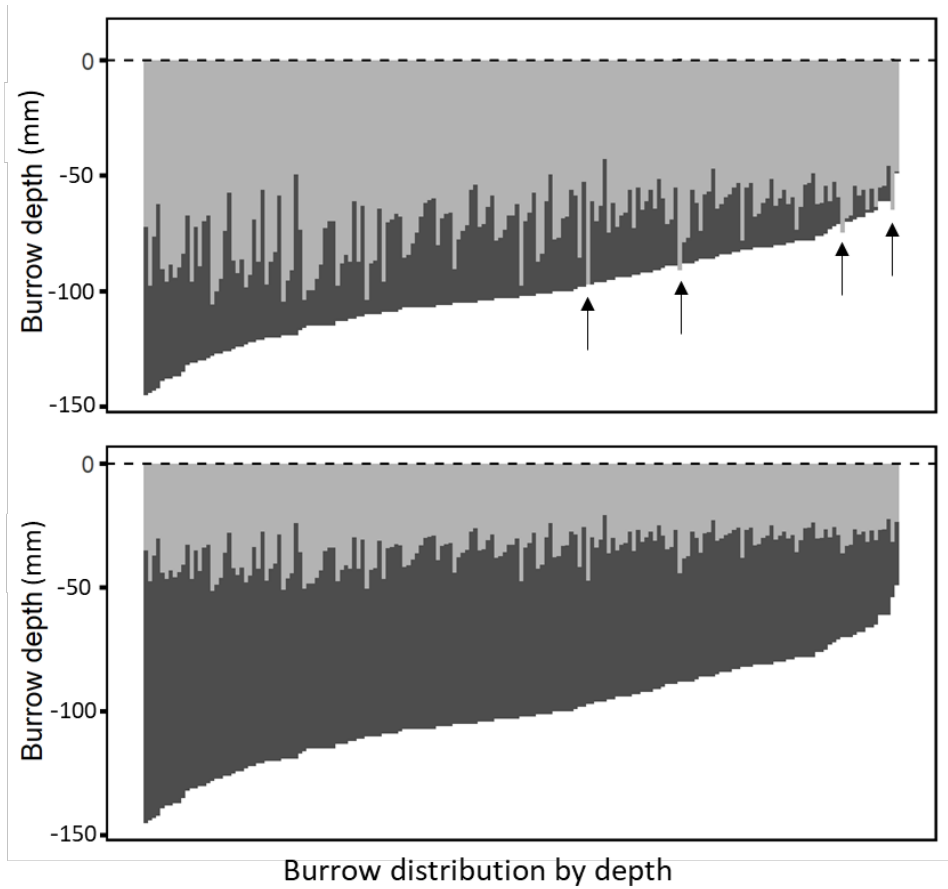
Figure 4. Theoretical maximum depth of direct solar radiation that would penetrate natural Lycosa hyraculus burrows at midday on a typical summer day in the Negev Desert Highlands. Burrows are ordered by depth. Penetration depth (light gray) was calculated using measured spider burrows diameters ( n = 181) and corresponding depths for solar zenith angles at 13:00 (9.3 ◦ , top) and at 14:00 (18.6 ◦ , bottom) on 24 June 2017. The length of each light grey line represents the depth of solar radiation penetration, and the lower boundary of the dark grey line corresponds to burrow depth. Burrows marked with arrows would receive direct radiation at the bottom of the burrow at 13:00 local